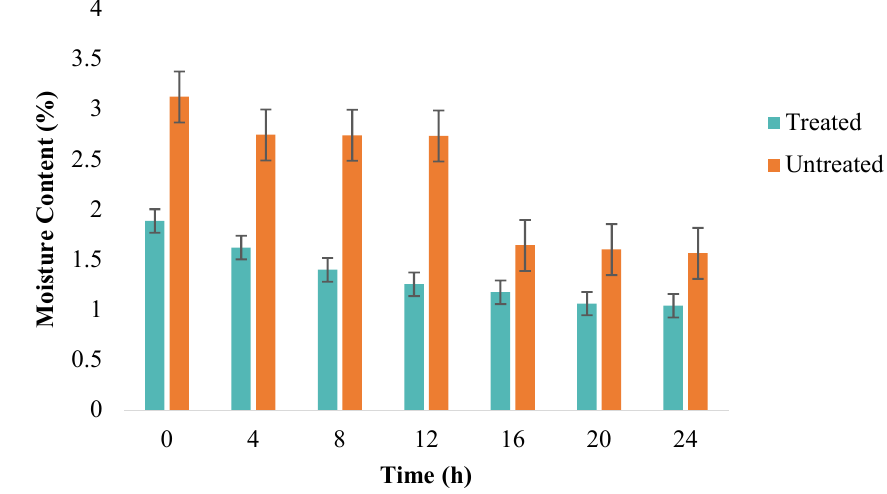
Figure 2. Moisture content of treated and untreated coffee husk fiber.